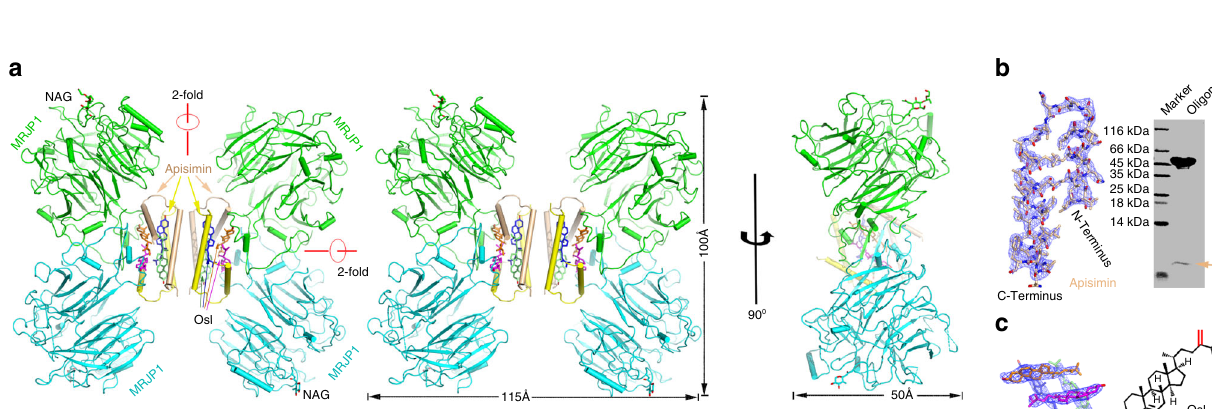
Fig. 1 Structure of the MRJP1 oligomer. a The H-like complex structure contains four MRJP1 (green or cyan), four apisimin (yellow or wheat), and eight 24-methylenecholesterol (blue, purple, orange, or lime sticks) molecules. N-acetylglucosamine (NAG) attached to Asn144 is shown in stick representation. The structure has two orthogonal twofold axes. Note that the stereoview is shown in the left and middle panels, a 90° rotation view in the right panel. The composite simulated-annealing mF o — DF c omit electron density maps of apisimin ( b ) and 24-methylenecholesterol ( c ) (also called Ostreasterol, Osl; formula shown in the right panel) are shown at 3.0 σ . The presence of apisimin (wheat arrow) was detected using tricine-SDS-PAGE